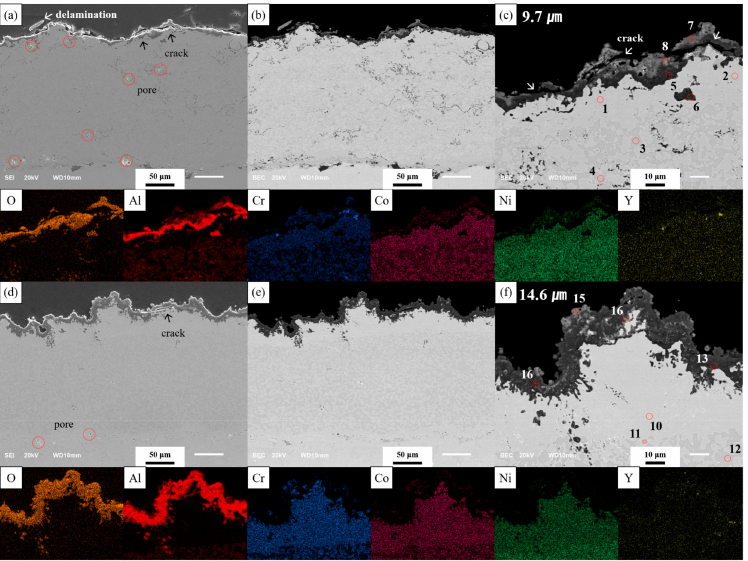
Figure 5. Microstructure and EDS analysis after FCT for HVOF ( a – c ) and VPS ( d – f )